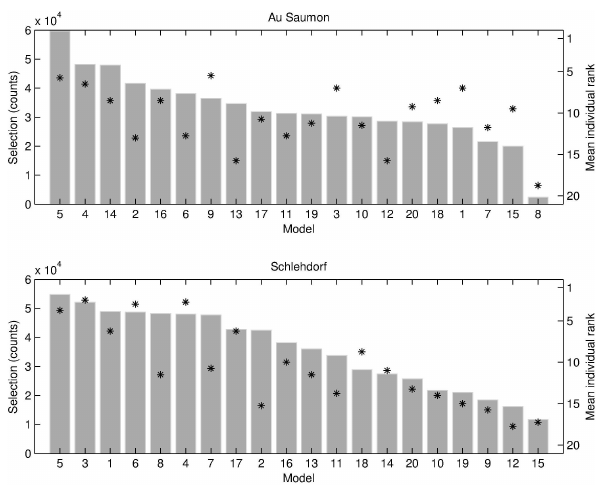
Fig. 14. Occurrence for each model in the selected ensembles for the Au Saumon (top panel) and Schlehdorf (bottom panel) catch- ments (grey bars), and mean individual rank (black